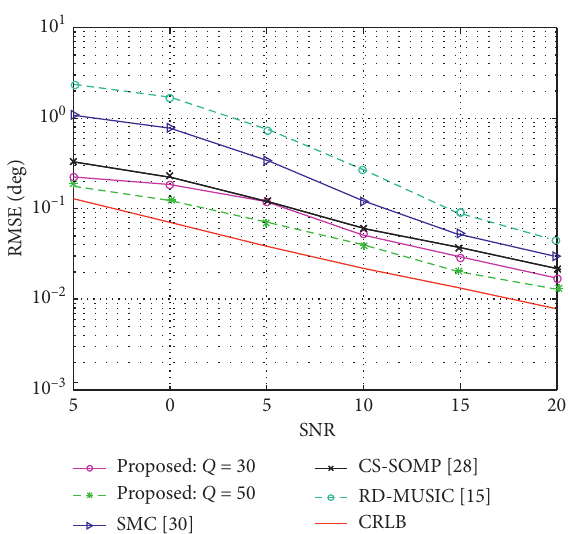
Figure 3: RMSE against varying